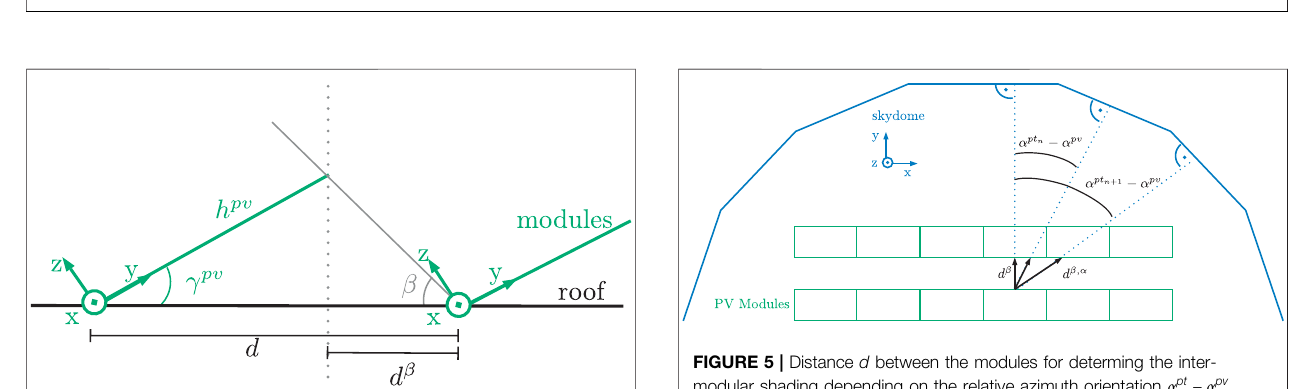
FIGURE 3 | (A) Annual irradiation on oriented PV modules in the climate zone of Geneva. (B) Annual irradiation on PV modules oriented between azimuth 80 ° – 280 ° and greater than 950 kWh/m2, visualization of tilt in 5 ° steps, azimuth in 1 ° steps.